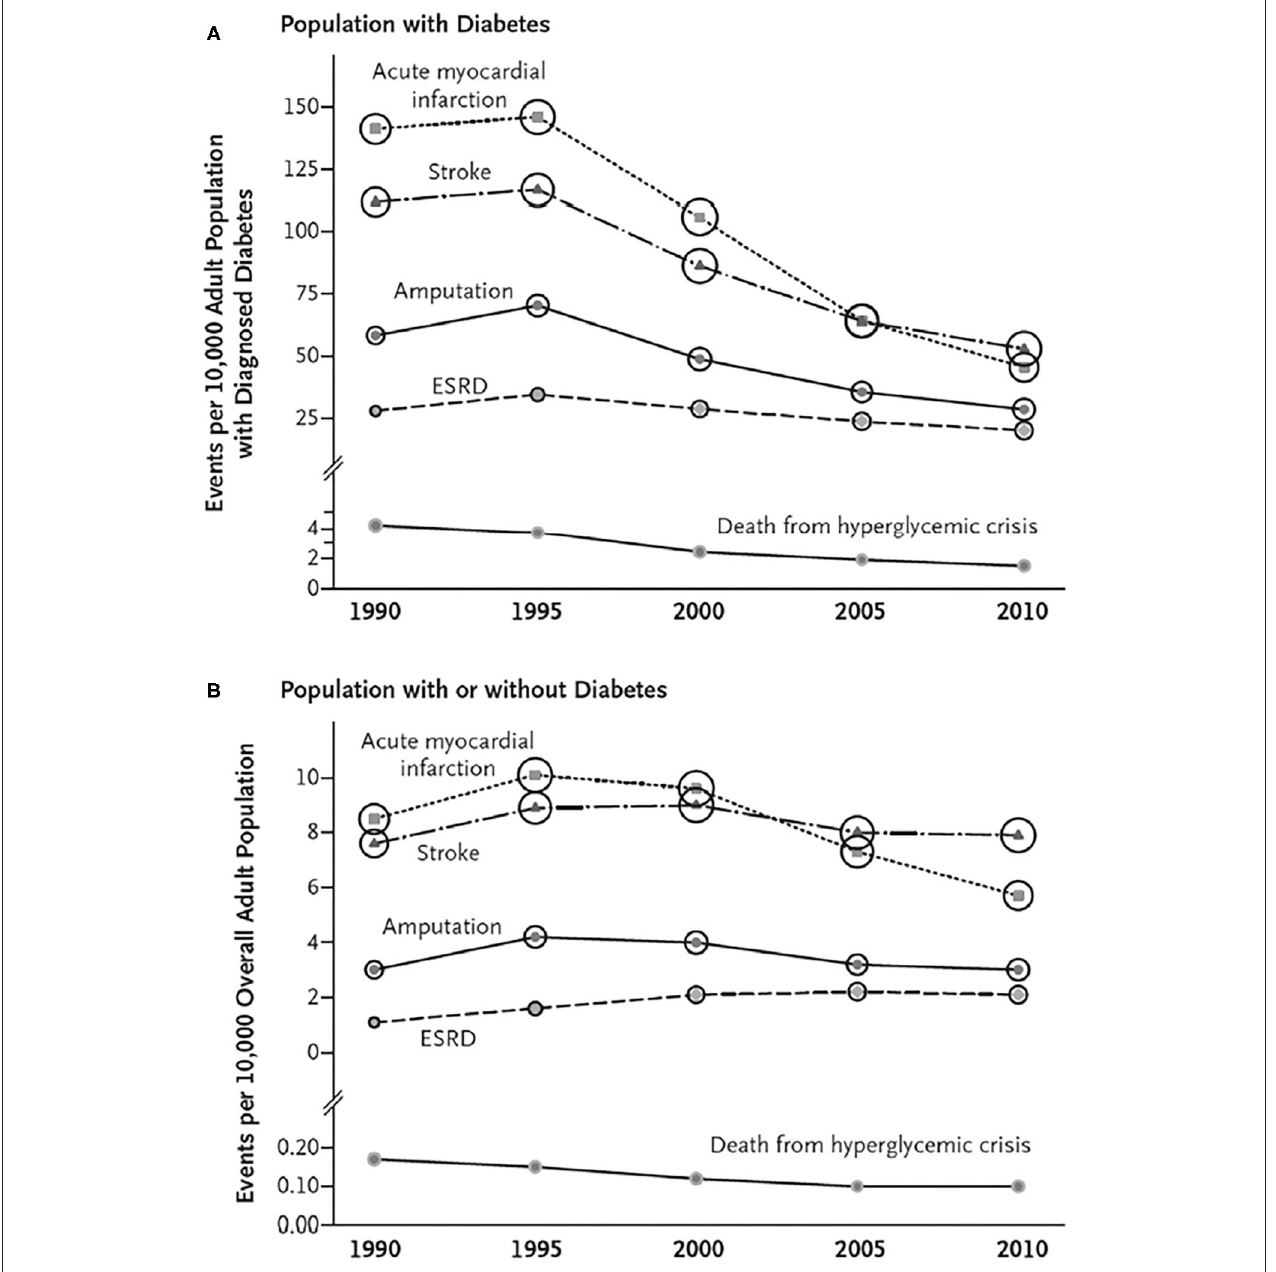
FIGURE 1 | Trends in Age-Standardized Rates of Diabetes-Related Complications among U.S. Adults with and without Diagnosed Diabetes, 1990–2010. For rates of myocardial infarction, stroke, and leg amputation, numerators are from the National Hospital Discharge Survey; for rates of end-stage renal disease (ESRD), numerators are from the U.S. Renal Data System, and for rates of death from hyperglycemic crisis, numerators are from the National Vital Statistics System. Denominators are from the National Health Interview Survey (A) and the U.S. Census Bureau (B) . Circle size is proportional to the absolute number of cases (e.g., the number of cases of acute myocardial infarction ranges from 140,122 in 1990 to 135,743 in 2010, and the number of cases of death from hyperglycemic crisis ranges from 2890 in 1990 to 2361 in 2010). (A) Shows trends for persons with diabetes, and Panel B shows trends for persons with or without diabetes [From (33); with